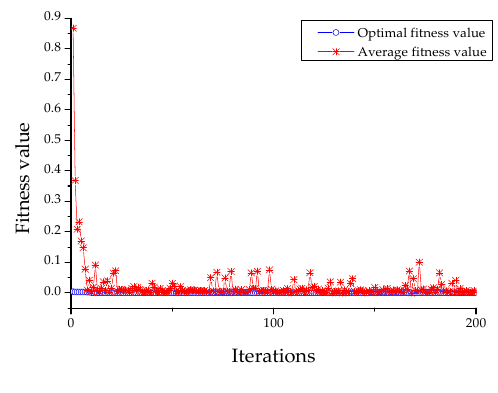
Figure 5. Fitness value curve. Table 2. Parameter selection results.